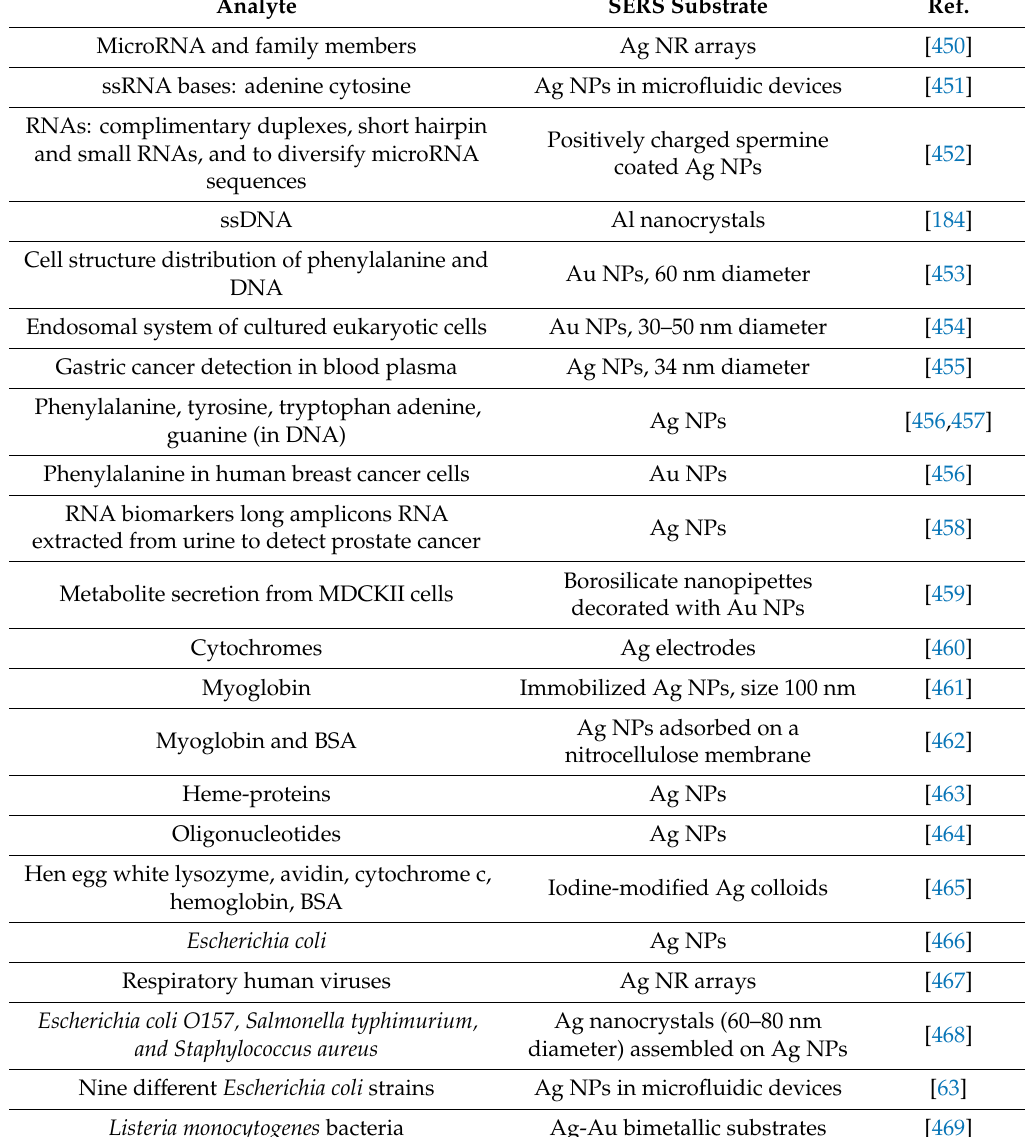
Table 8. Summary of the SERS applications in the biomedical field presented in this review (direct protocol).